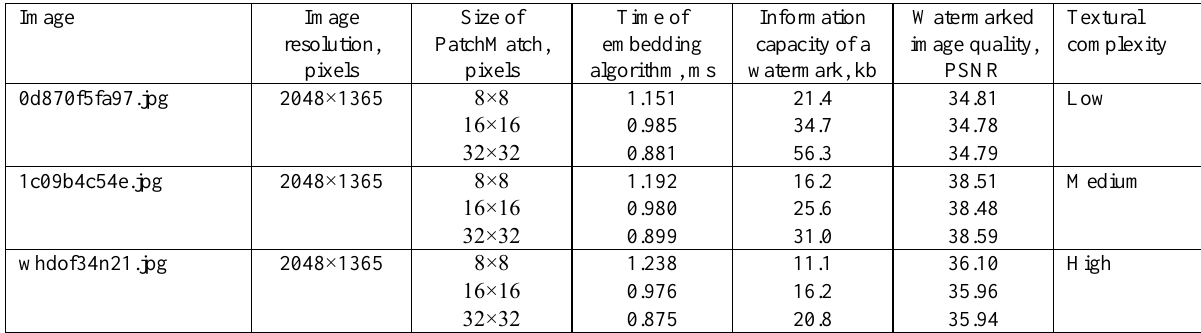
Table 1 . Assessment of the watermark information